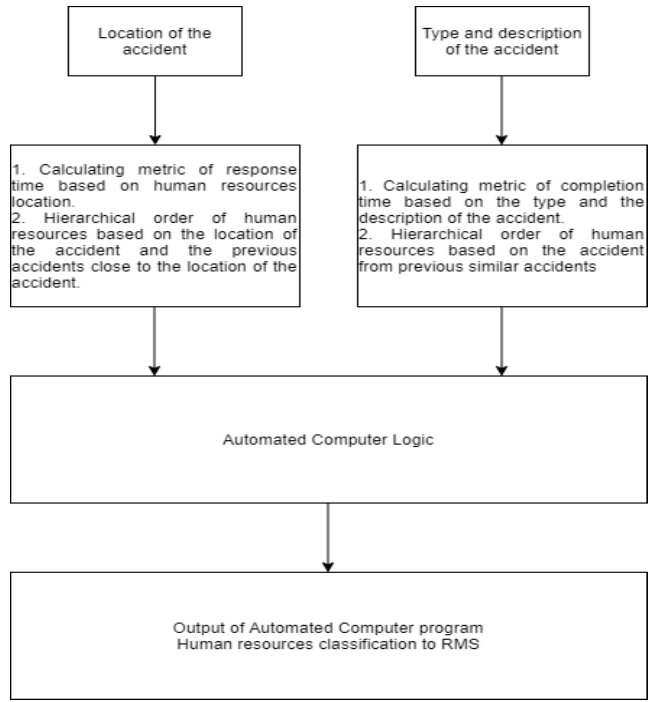
Figure 4. Illustration of the RMS functionality of machine learning algorithms—metrics calculation and intelligent agents.